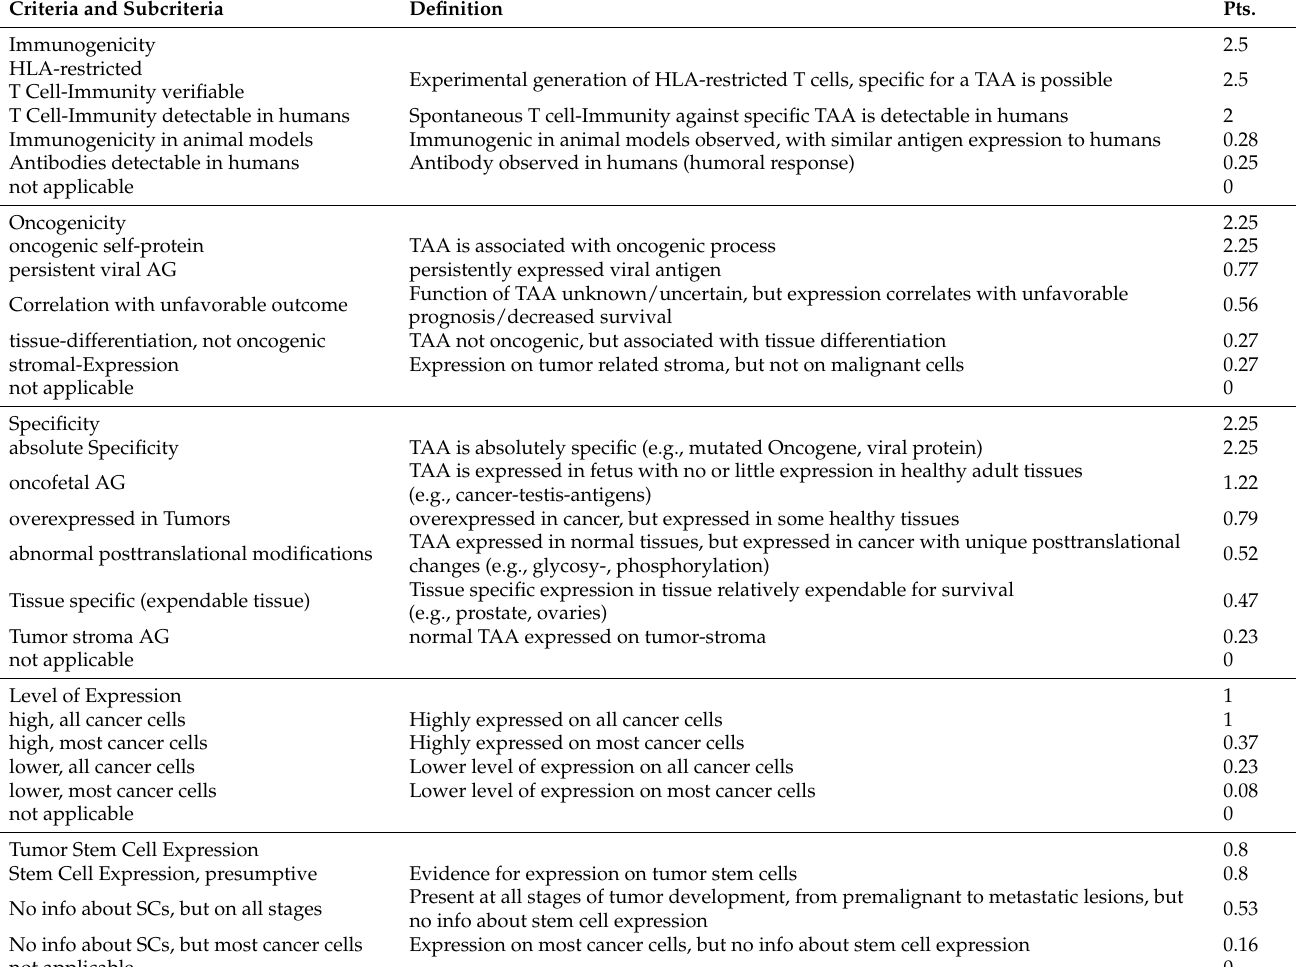
Table 2. Evaluation criteria and subcriteria for the TAAs, modified after Cheever et al. [27] A total of ten points could be obtained in seven